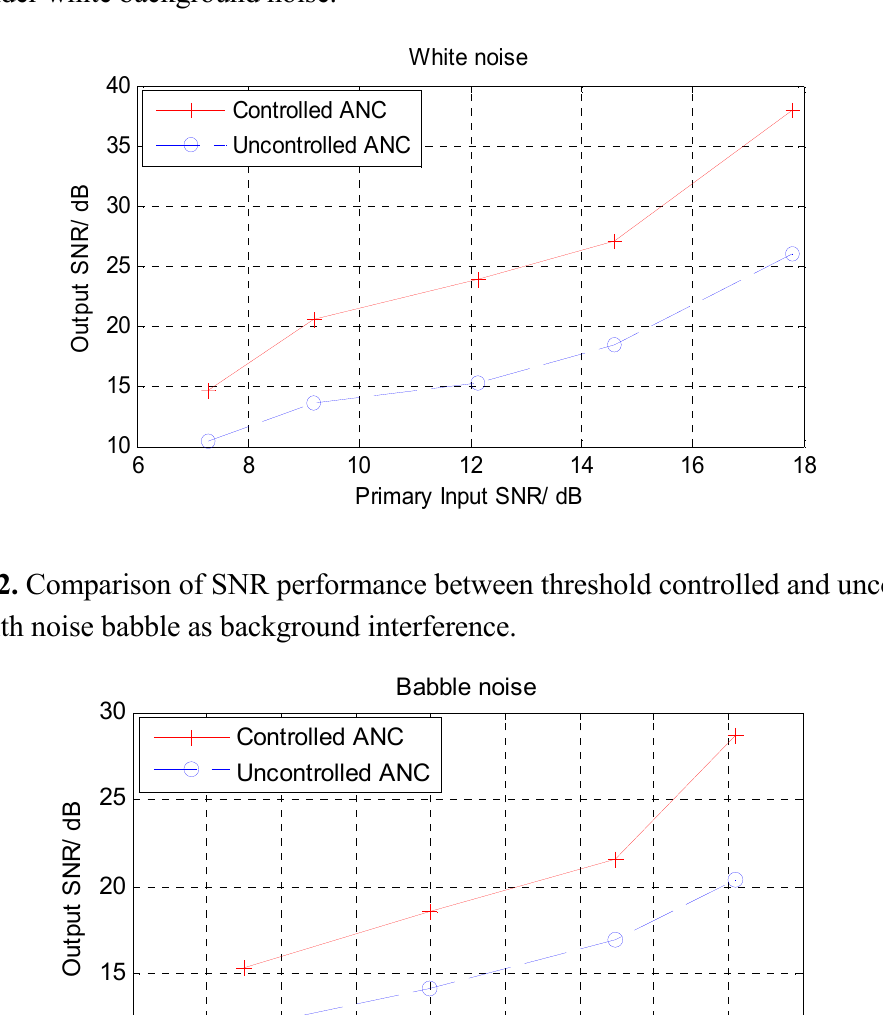
Figure 11. Comparison of SNR performance between threshold controlled and uncontrolled ANCs under white background noise.